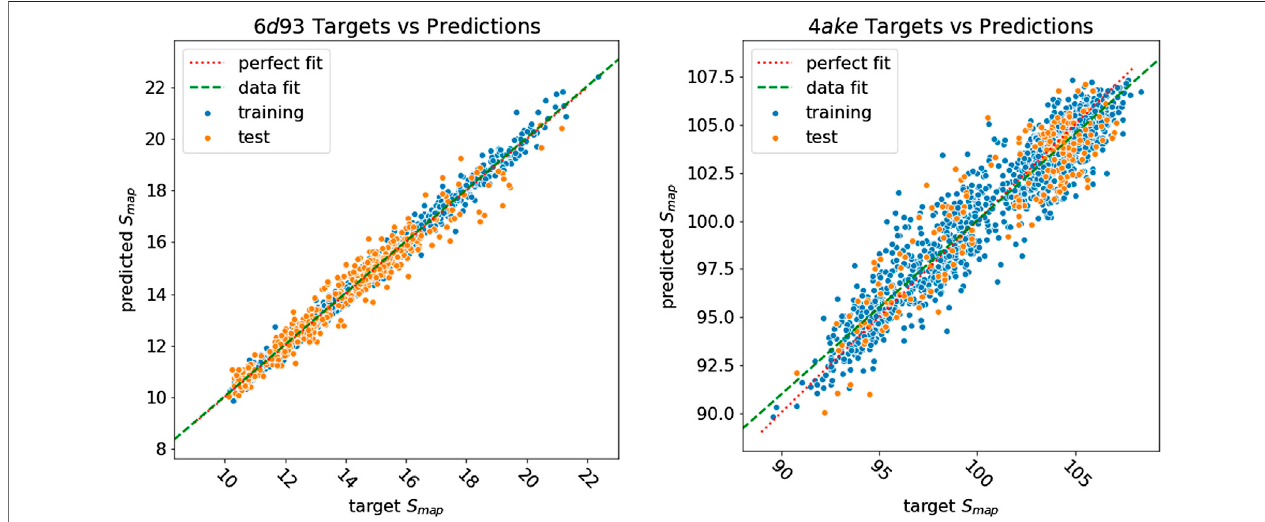
FIGURE 8 | Plot of S map target values against predictions of all samples for 6d93 (left) and 4ake (right) . Training samples are in blue, while test samples are in orange. A perfect prediction is represented by points lying on the red dotted diagonal line (perfect fi t). To show that in the case of 4 ake , the model slightly overestimates